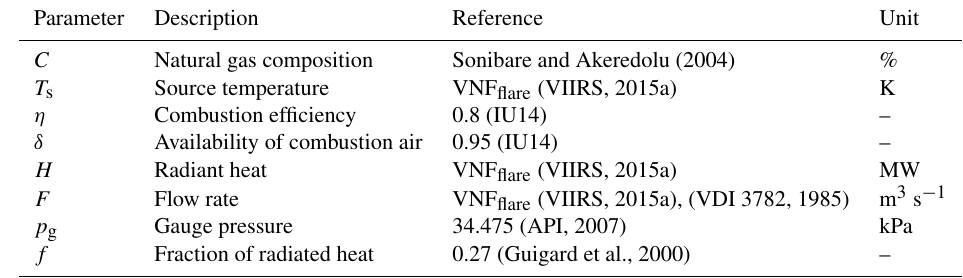
Table 2. Variables and parameters needed for IU14 or for deriving the fluxes of the air pollutants.